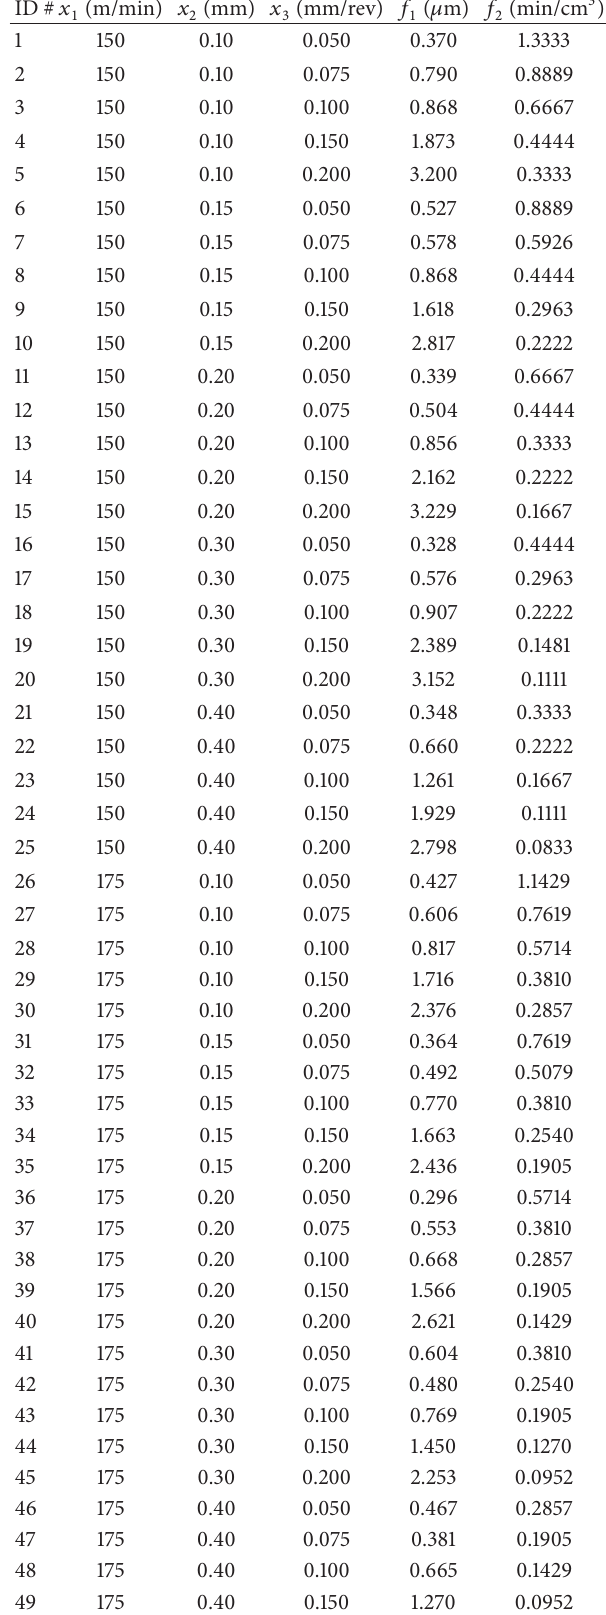
Table 6: Listing of five-level full-factorial